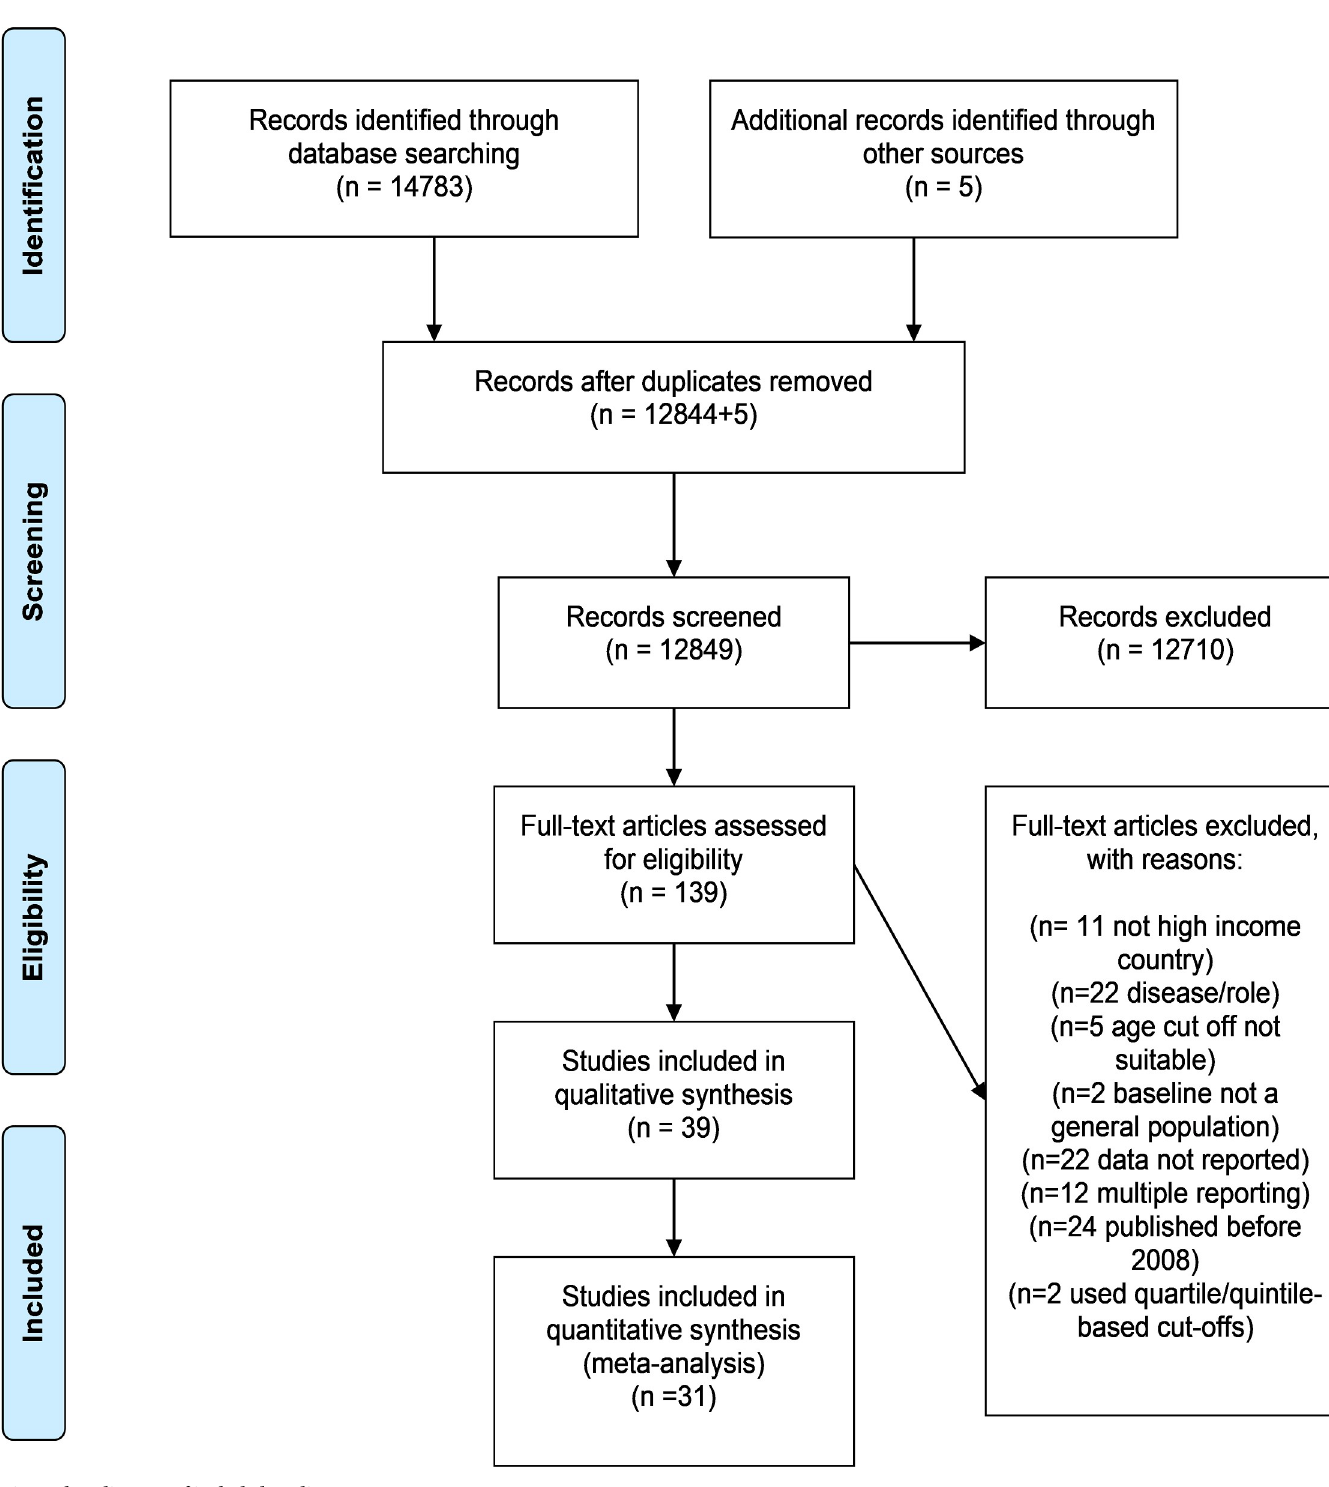
PLOS ONE | https://doi.org/10.1371/journal.pone.0255088 July 26,